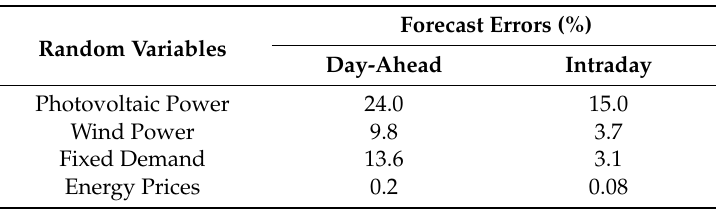
Figure 3. Reduced scenarios of fixed demand minus renewable energy sources (RES) generation to participate in ( a ) Day-ahead market and ( b ) Intraday markets. Table 3. Normalized mean squared errors of random